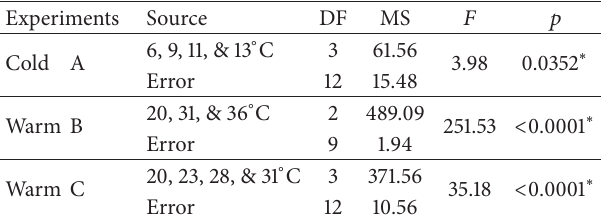
Table 2: One-way ANOVA on the final survival for Mytella charruana thermal tolerance